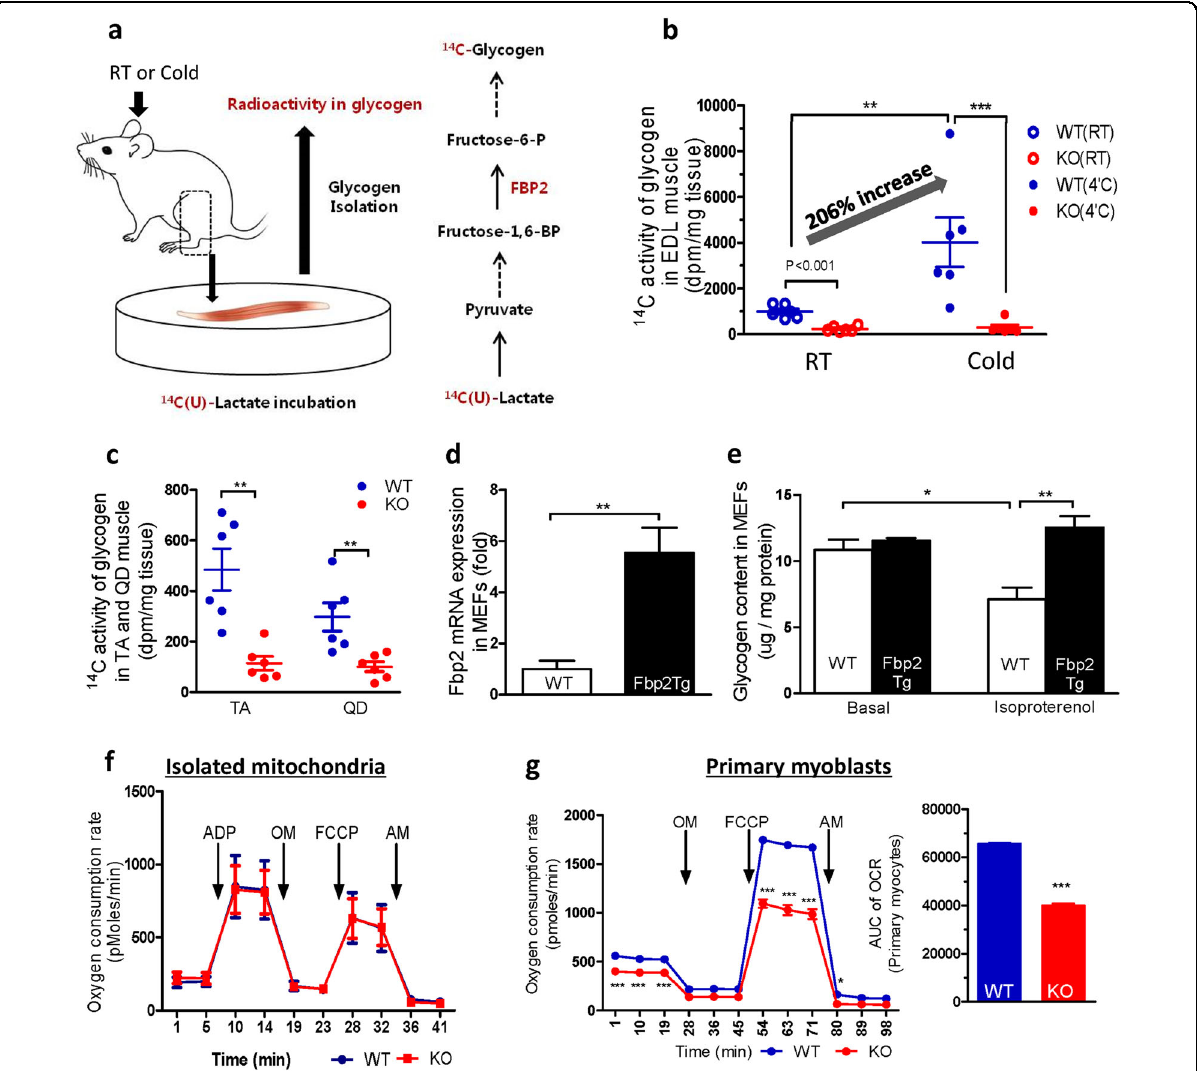
Fig. 4 Fbp2 was necessary for intramuscular glyconeogenesis and in fl uenced mitochondrial respiration. a Schematic diagram of the ex vivo study of 14 C(U)-lactate incorporation into glycogen. b Results of 14 C(U)-lactate incorporation into glycogen in the EDL muscles of WT and Fbp2 KO mice under basal conditions and after cold stress, n = 6 per group. c Results of 14 C(U)-lactate incorporation into glycogen in the TA and QD muscles of WT and Fbp2 KO mice after cold stress, n = 6 per group. d Fbp2 gene expression in MEFs isolated from WT and Fbp2 Tg mice analyzed by quantitative RT-PCR, n = 6 per group. e Glycogen content assay in MEFs isolated from WT and Fbp2 Tg mice under isoproterenol-treated glycogenolytic conditions, n = 4 per group. f Isolated mitochondrial respiration analysis of WT and Fbp2 KO mice, n = 6 per group. g Cellular respiration analysis (left) and area under the curve of the oxygen consumption rate (right) of primary myoblasts isolated from WT and Fbp2 KO mice, n = 3 per group. EDL extensor digitorum longus, TA tibialis anterior, QD quadriceps, MEFs mouse embryonic fi broblasts, Tg transgenic, ADP adenosine diphosphate, OM oligomycin, FCCP carbonyl cyanide-4-(tri fl uoromethoxy)phenylhydrazone, AM antimycin. Data are expressed as the mean ± SEM. * P < 0.05, ** P < 0.01, *** P < 0.001 by one-way ANOVA for ( b ), ( e ) and two-way ANOVA for f , ( g , left). ** P < 0.01, *** P < 0.001 by Student ’ s t -test for c – d , ( g ,